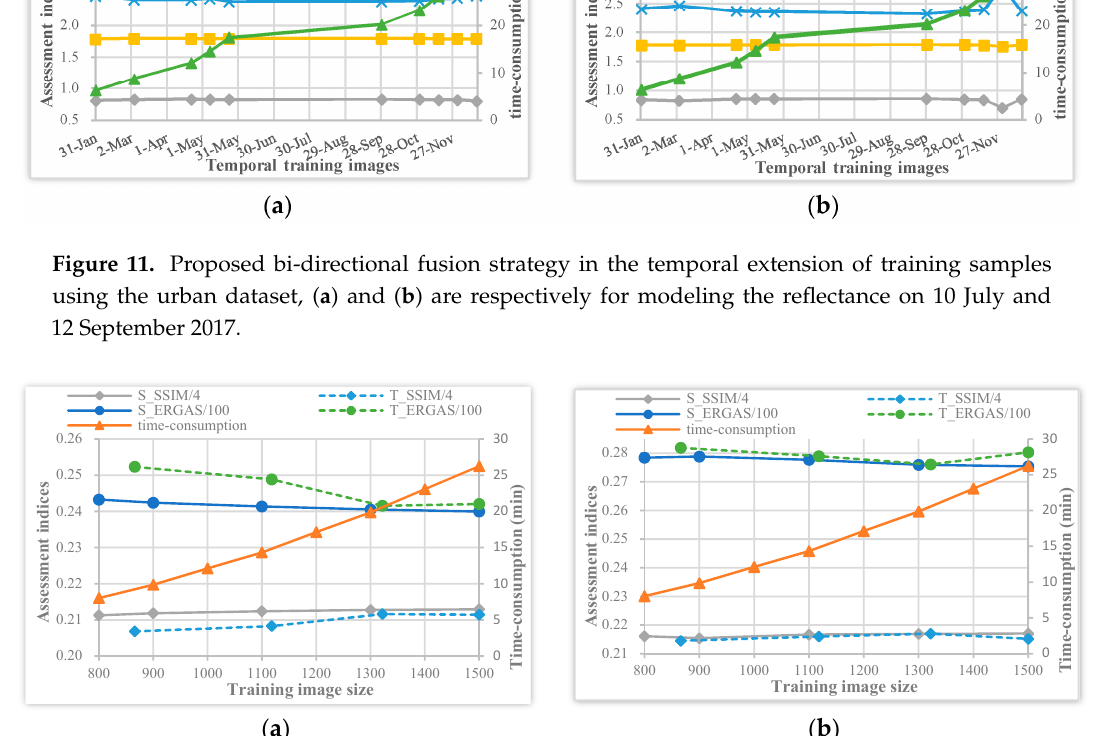
Figure 12. Quality and efficiency of proposed bi-directional fusion with the spatiotemporally extended training samples from the urban dataset, ( a ) and ( b ) are respectively for the spatially extended mode and the temporally extended mode.